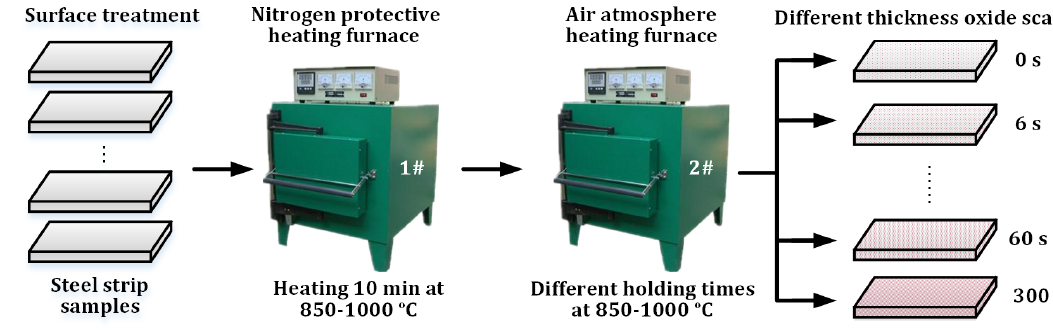
Figure 1. Sketch diagram of the oxide scales preparation.